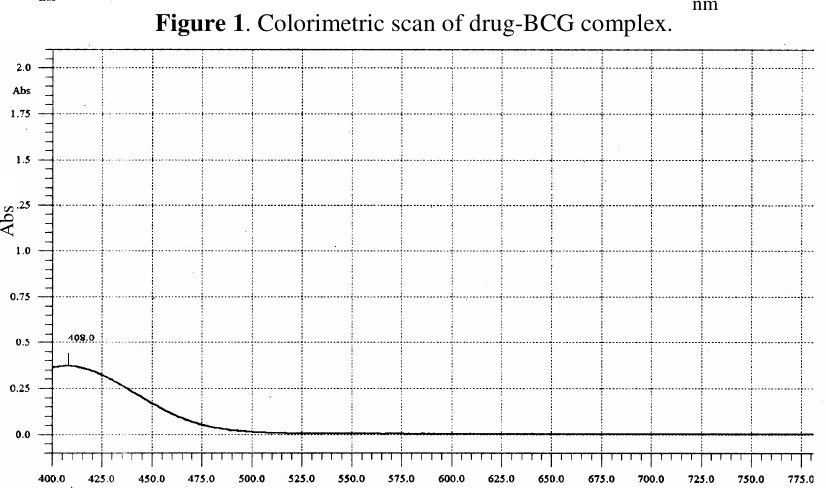
Figure 1 . Colorimetric scan of drug-BCG complex.